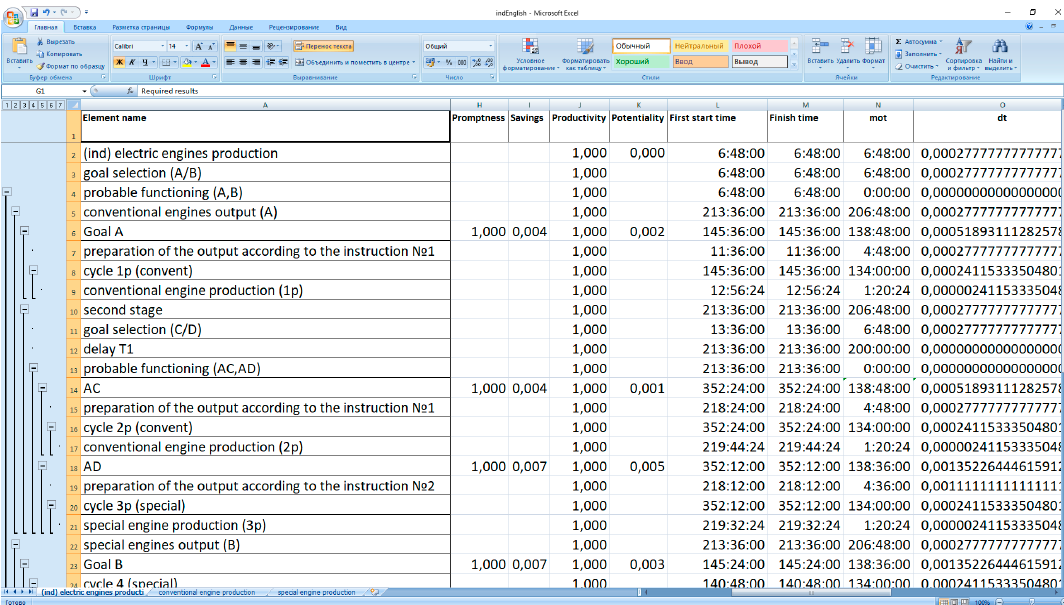
Figure 10. Program model to estimate operational properties of information operations, corresponding